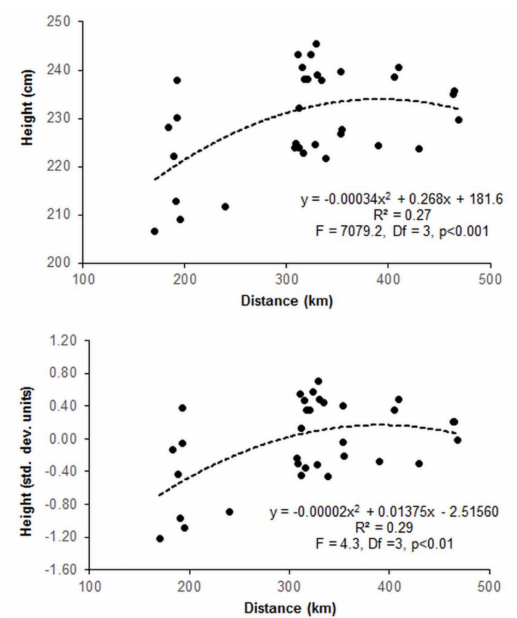
Figure 7. Relationships between the mean heights reached at an age of 15 years by trees of the tested provenances and the geographic distance between their origin sites and the meeting zone of the refugial lineages. Tree height is expressed both in nominal and standardized units for each test site. The dots show the mean tree heights of 33 tested provenances from the western lineage on eight test sites.